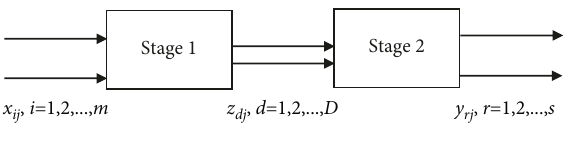
Figure 1: Two-stage